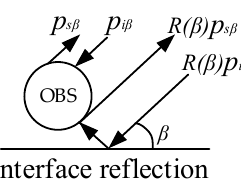
Figure 7. Acoustic wave on the surface of the OBS.